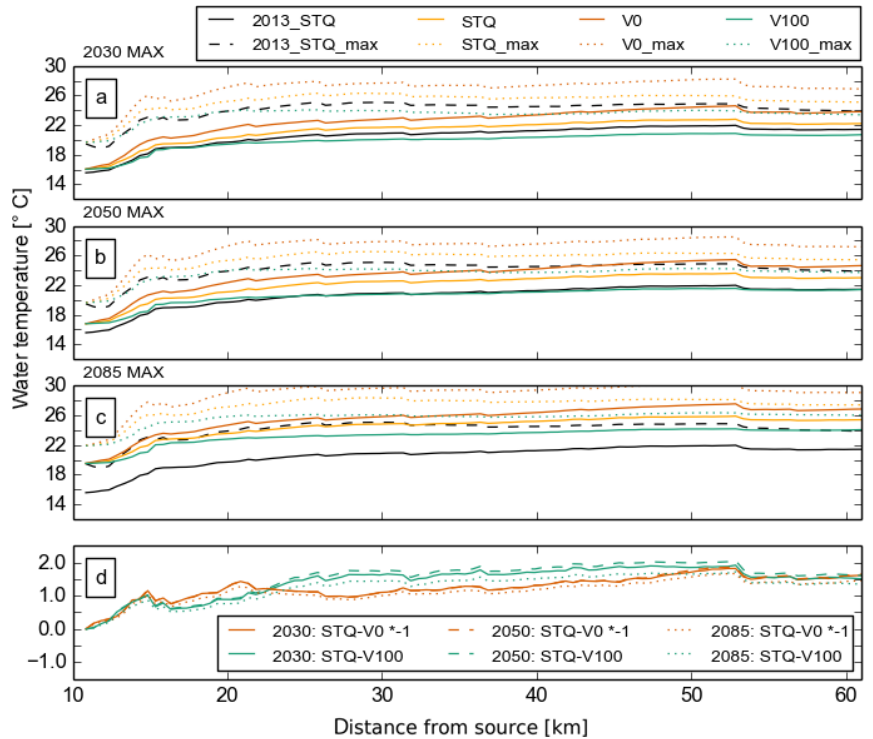
Figure 5. Mean and maximum water temperatures averaged during the maximum events predicted for the climate periods centred on (a) 2030, (b) 2050 and (c) 2085 along the Pinka using vegetation scenarios V0 (no vegetation), STQ and V100 (full vegetation) in comparison to the maximum event recorded in 2013. (d) The difference between STQ and V100 (green) and STQ and V0 ( ∗ − 1)